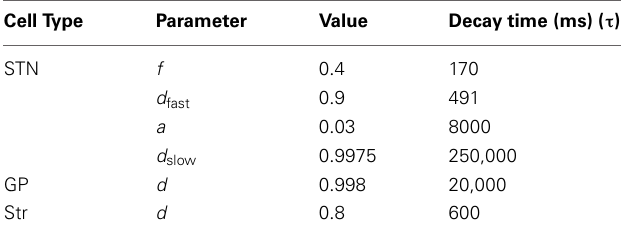
Table 2 | Synaptic parameters.